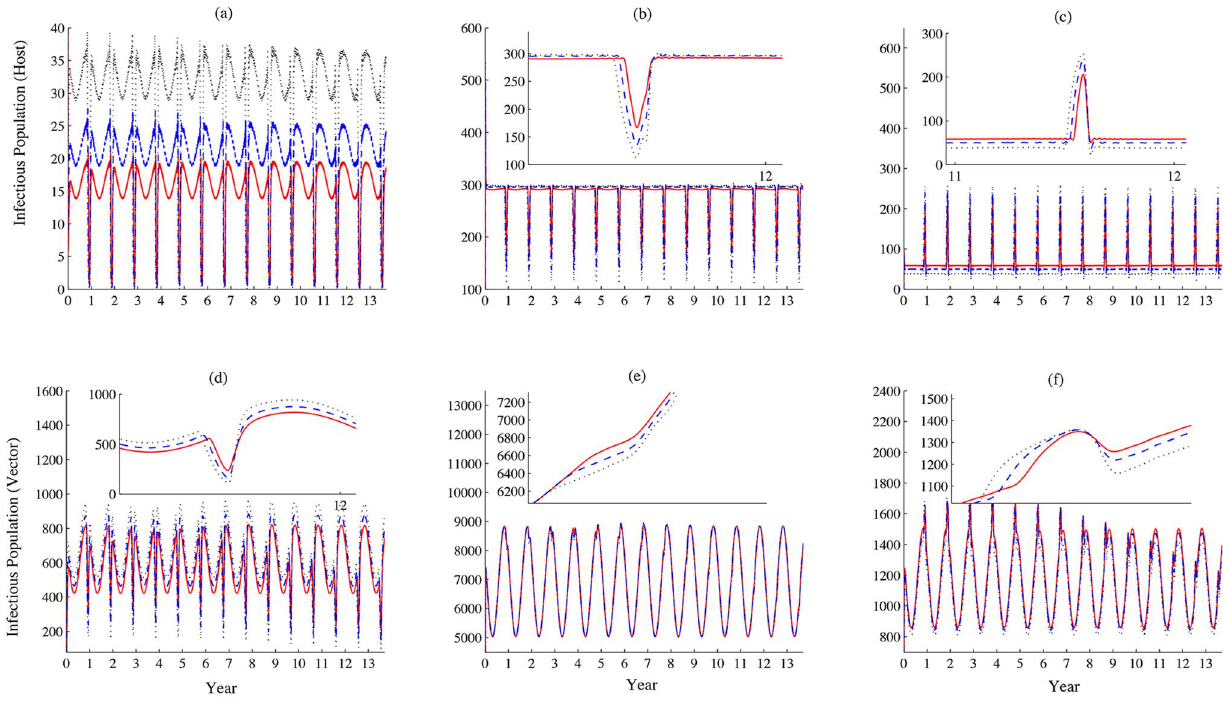
Fig. 11. How the starting time of festival preparation impacts patterns of disease outbreaks: infectious classes. (a)-(c) and (d)-(f), simulations of the populations of infectious livestock and vectors in patches 1–3, respectively. The starting time of festival preparation varies from 2, 3, to 4 weeks ago (n= 14,21,28 days), represented by solid, dashed and dotted lines, respectively. Values of other parameters are identical with those used in Fig. 3 and dc ~ 54 km = day , d (cid:2) mm ~ 0 : 02, dr ~ 40 . Unit: daily. When the preparation starts early, we are expecting a larger scale of disease outbreaks due to the higher concentration of livestock, larger scale infectious population appear in patches 1 and 3. However, less number of infectious individuals exist due to the exposed period in patch